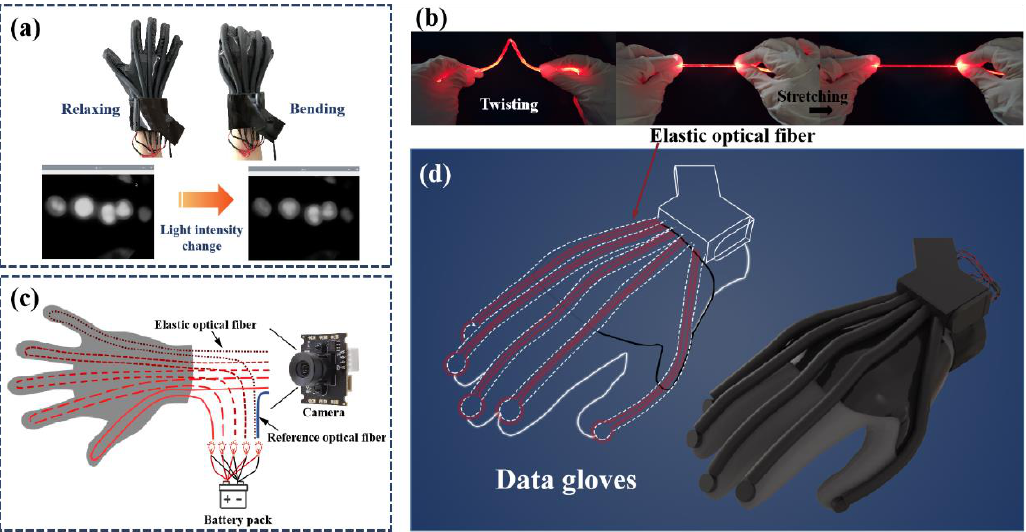
Figure 1. ( a ) Comparison of optical source before and after being affected by factors such as current. ( b ) Deformation display of the fiber. ( c ) The structure of the self-compensation module. ( d ) Structure diagram of data glove.